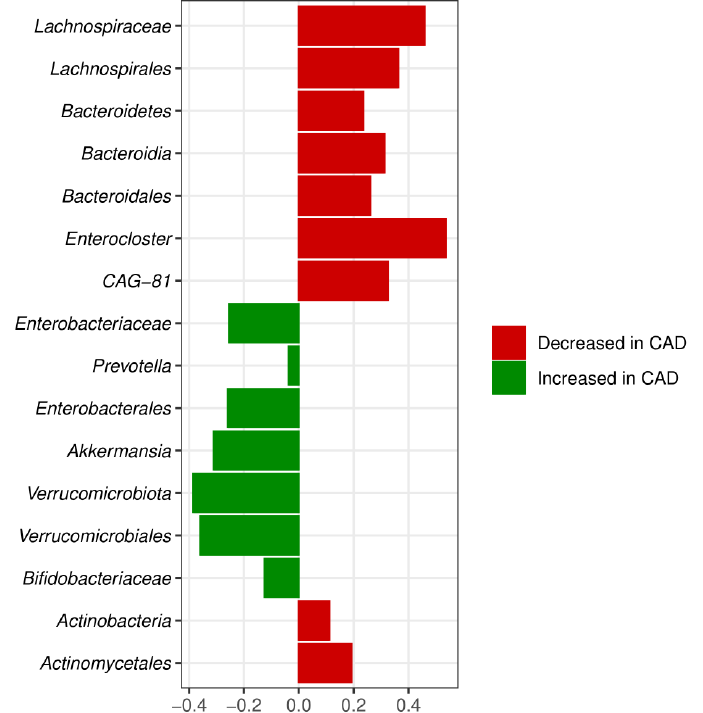
Figure 8. The results of a meta-analysis. Only bacteria detected as statistically significant metagenome- Seq, Ancom-BC, or DESeq2 in at least three of seven studies were included. Relative abundances (reported as log-fold change) for the pooled